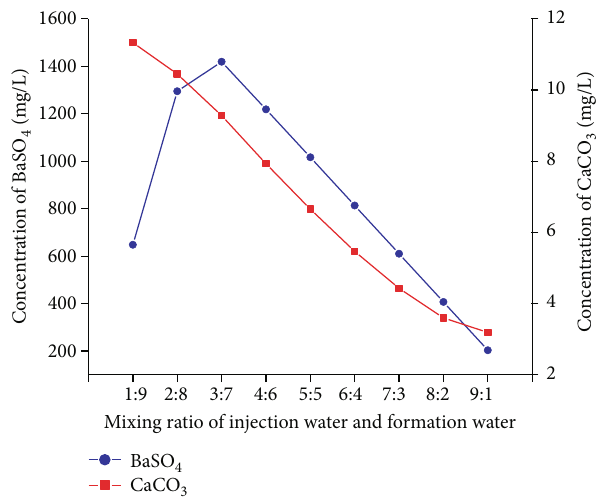
Figure 1: Scaling type and tendency of mixed water at di ff erent mixing ratio